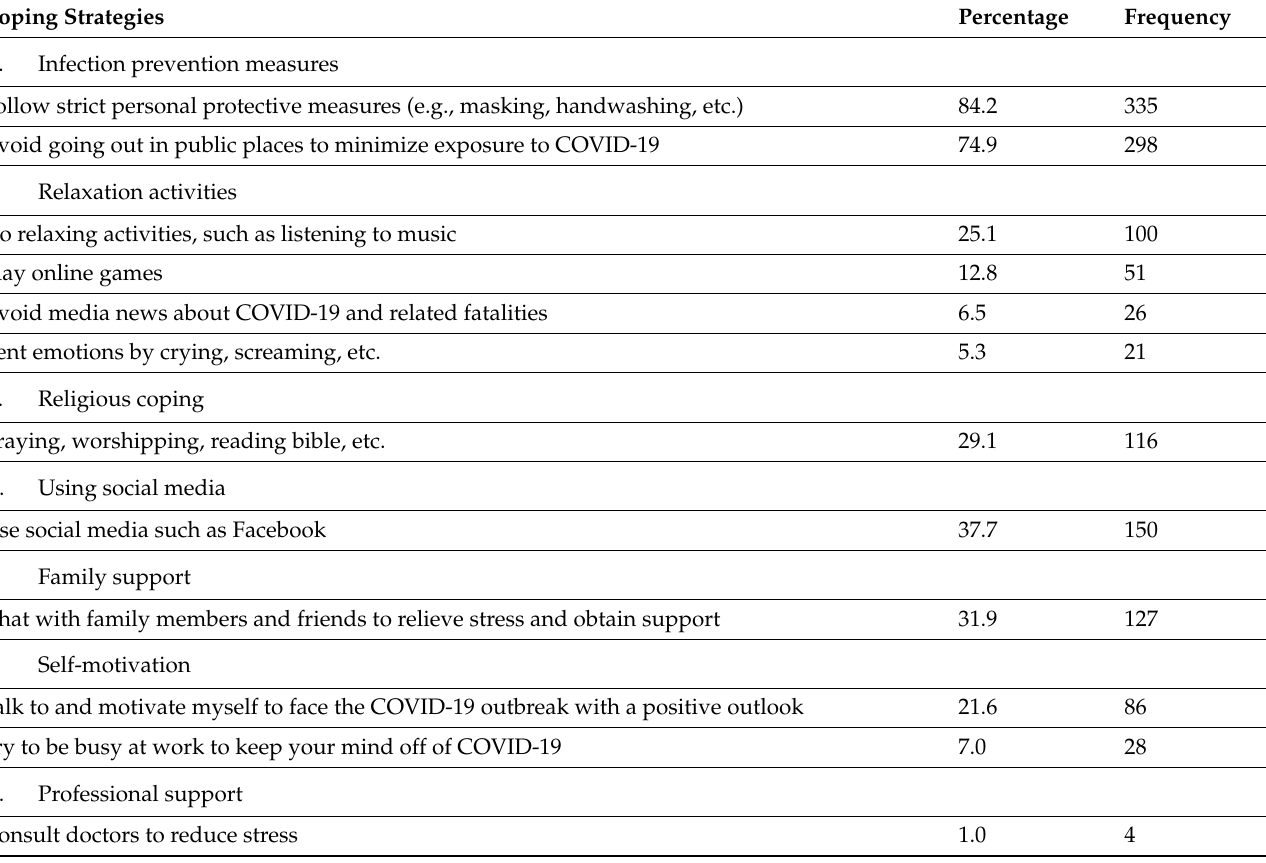
Table 3. Coping strategies for COVID-19 infection and mental